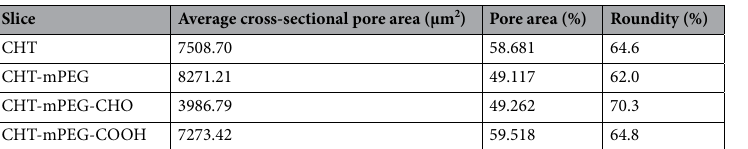
Table 2. Porosity parameters for CHT/mPEG cryosponges computed using ND image processing.